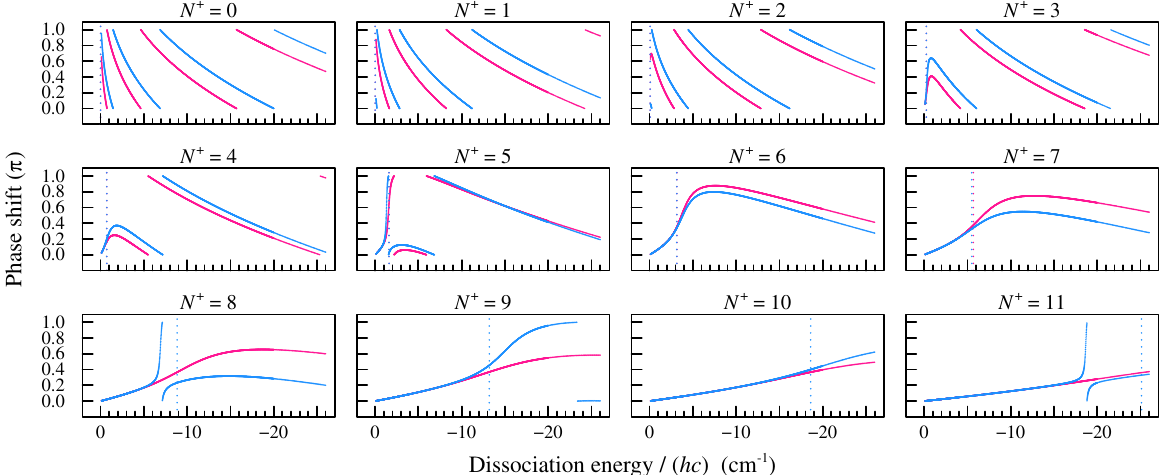
FIG. 2. Energy dependence of the individual partial wave scattering phase shift η X þ (blue) and A þ states (red) for the angular-momentum channels N þ ¼ 0 – 11 at low energies. The dashed lines indicate the positions of the maxima of the centrifugal